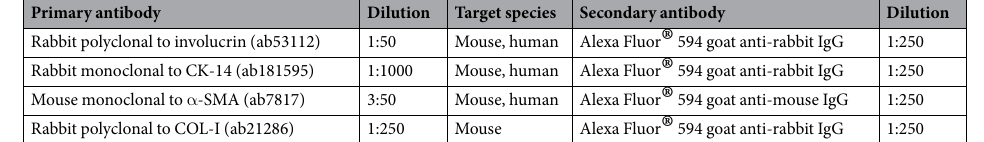
Statistical analysis.